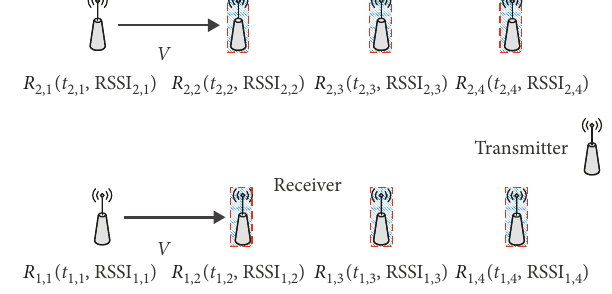
Figure 15: Schematic of the generation of virtual